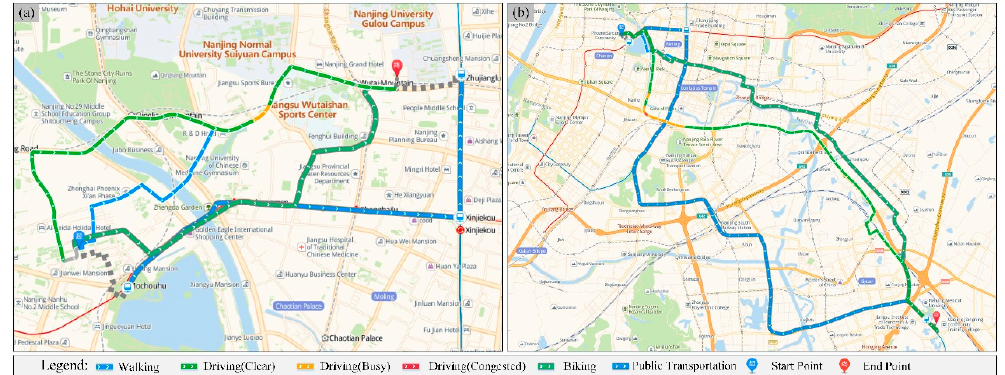
Figure 5. The MTM trajectories of two selected empirical origin–destination pair (OD) flows. Figure 5a is short trip from Yujinli Community to NCHGZ, and Figure 5b is long distance trip from Yujinli Community to YHANMU. Table 2. The d ij and f ( d ij ) logbooks for two empirical OD flows (from Yujinli to NCHGZ and to